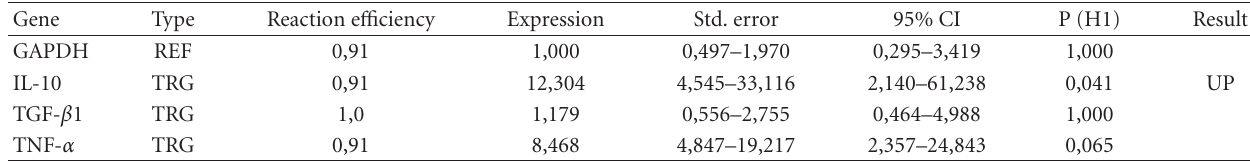
Table 2: Statistical analysis summary of results obtained from ginseng versus control after processing RT-PCR data through REST (Relative Expression Software Tool) in 20th